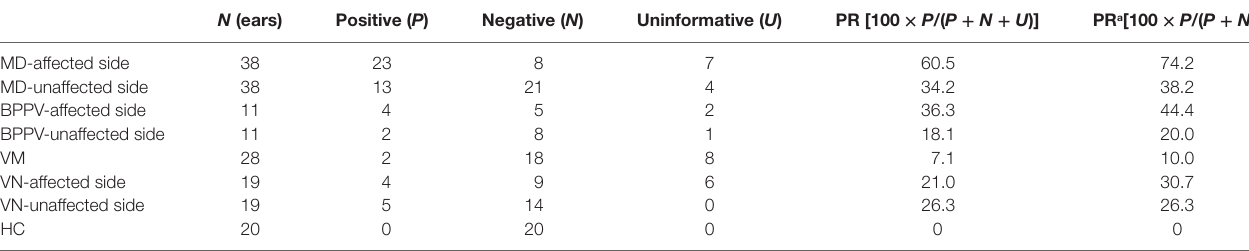
Table 2 | Positivity rate in each